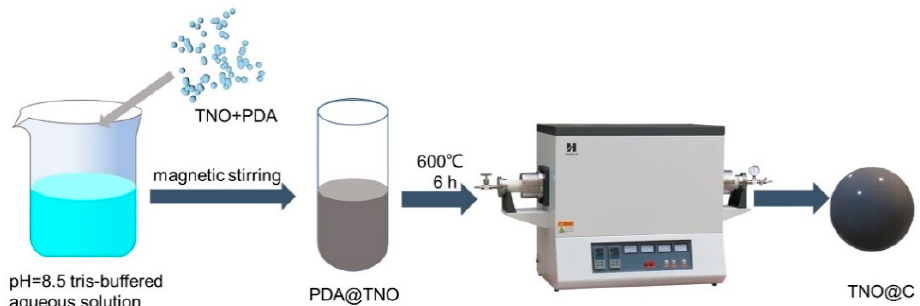
Figure 1 . Schematic diagram of the preparation of TNO@C. Figure 1. Schematic diagram of the preparation of